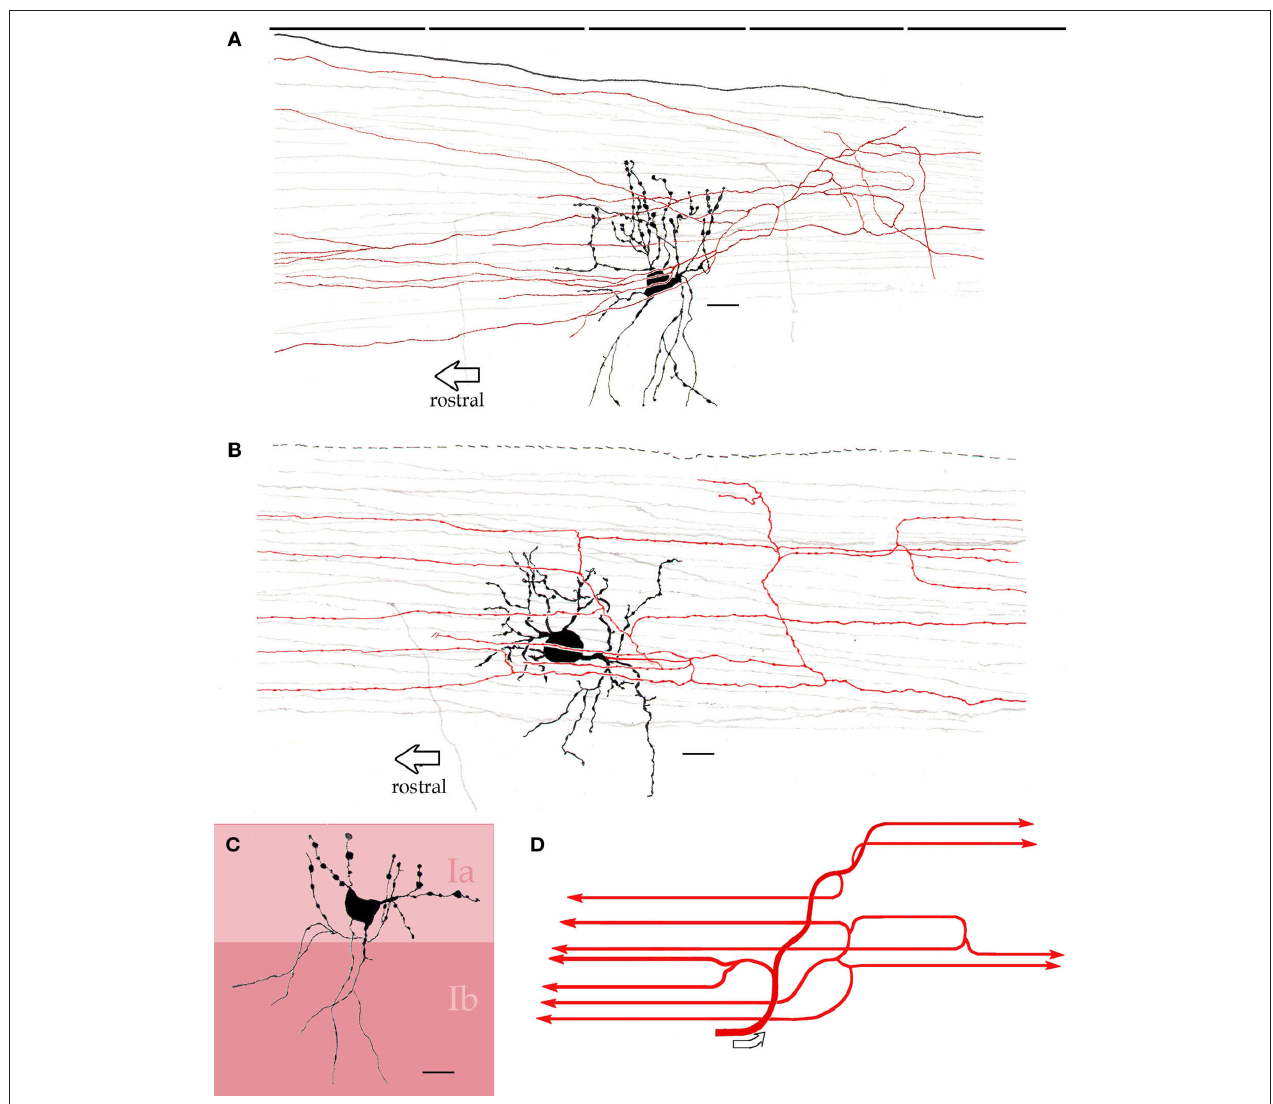
Figure 6 | interfascicular neurons in the piriform cortex. (A) An interfascicular neuron bearing a triangular-shaped soma gives rise to paired sets of asymmetrical dendrites. The axon (red) divides repeatedly running horizontally. (B) Interfascicular neuron with a rounded soma. The axon (red) is confined to